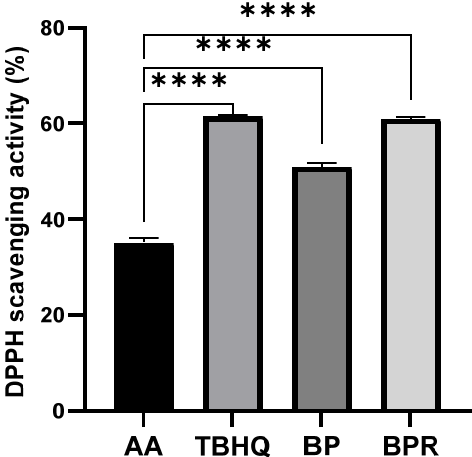
Figure 2. In vitro DPPH scavenging activity of the extracts. Different numbers of asterisks represent significant statistical differences (**** p < 0.001), n = 3.